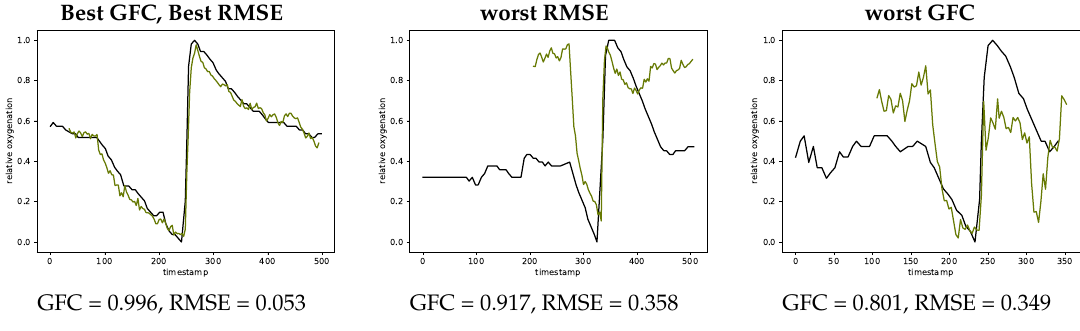
Figure 12. Extreme curves with best GFC and best RMSE ( left , #V56-1) worst RMSE ( middle , #V07-1) and worst GFC ( right , #V39-1) metrics. INVOS measurement in black and SFA estimation in green.